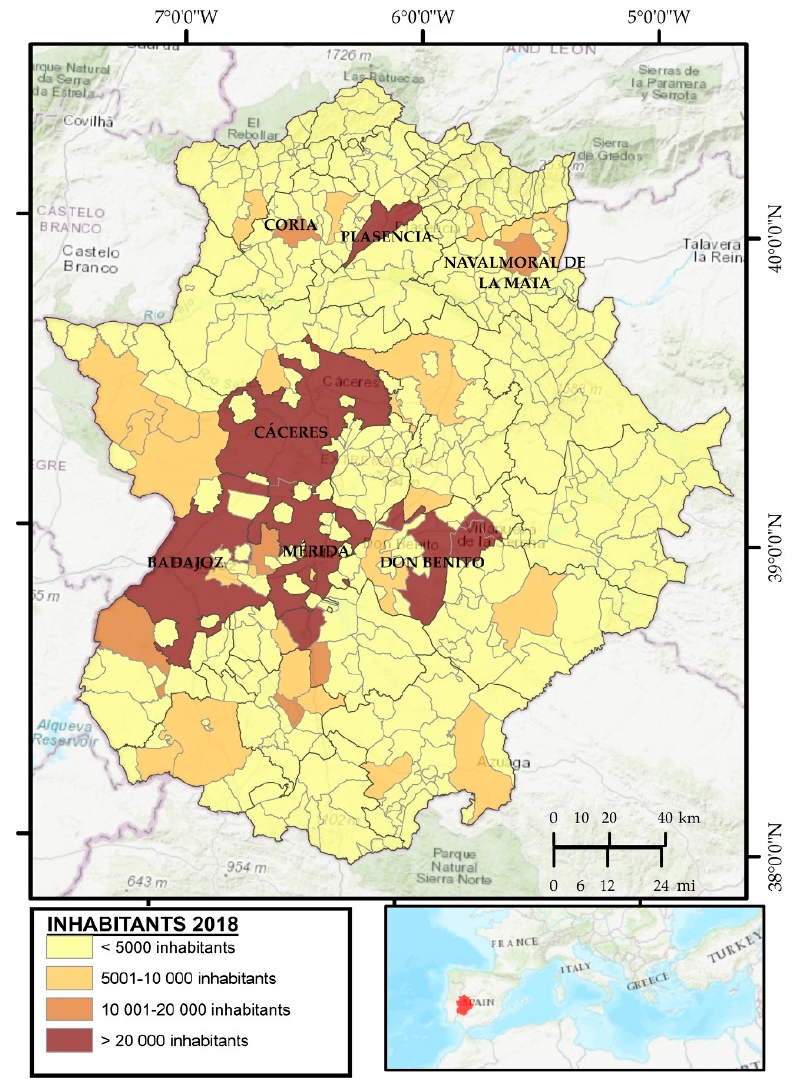
Figure 1. Inhabitants by municipalities 2018.